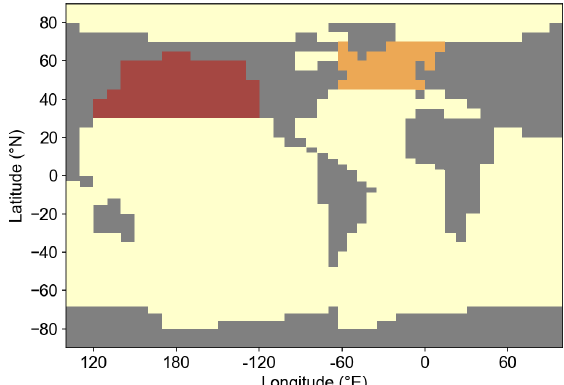
Figure B1. Map depicting regions where freshwater and saltwa- ter perturbations are applied. For the hosing experiments, the fresh- water was evenly applied to the North Atlantic (orange). In order to achieve weakened LGM AMOC states, small freshwater fluxes were added to the North Atlantic (orange) and compensated for in the North Pacific (red) by adding the equivalent salt flux to that re-